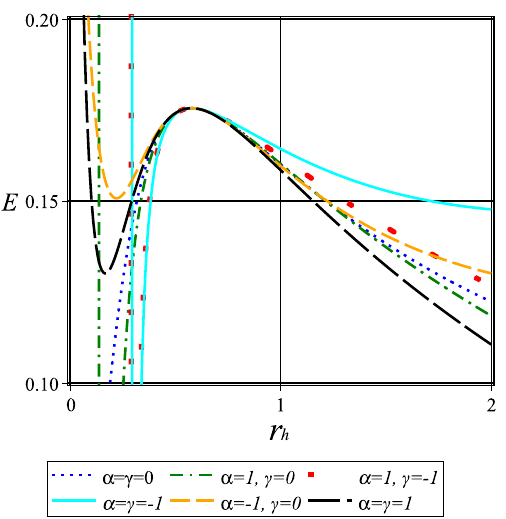
Fig. 3 Specific heat of LMP solution in spherical space in terms of the black hole horizon for l = 1 and a = 10